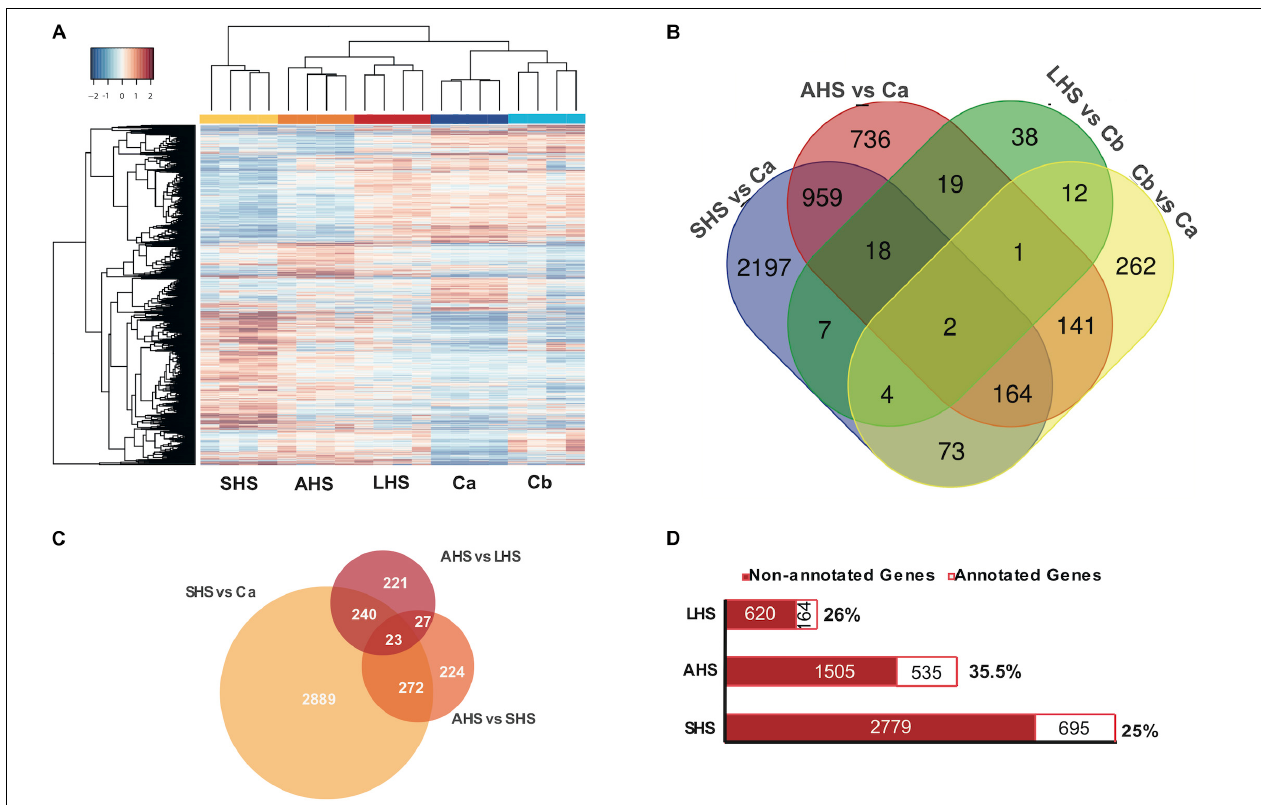
FIGURE 2 | Differential Expression Analysis. (A) Heatmap depicts the clustering of all the differentially expressed genes, based on FDR < 0.01 along the different conditions. Colors from blue to red indicate the increasing expression. (B) Venn diagram presenting the amount of differentially expressed genes in each treatment condition (SHS, AHS, LHS) compared to the corresponding control condition Ca, Cb as also in the comparison between the two control conditions. (C) Venn diagram representing the differentially expressed genes in each treatment condition when compared among themselves in a gradual increase from Ca to SHS, from SHS to AHS, and from AHS to LHS. (D) Bar graph depicting the amount of differentially expressed genes in each thermal condition that are annotated and have an associated GO term. SHS, Short heat Shock; AHS, Acute Heat Shock; LHS, Long Heat Shock; CT, Control tank; TT, treatment tank.